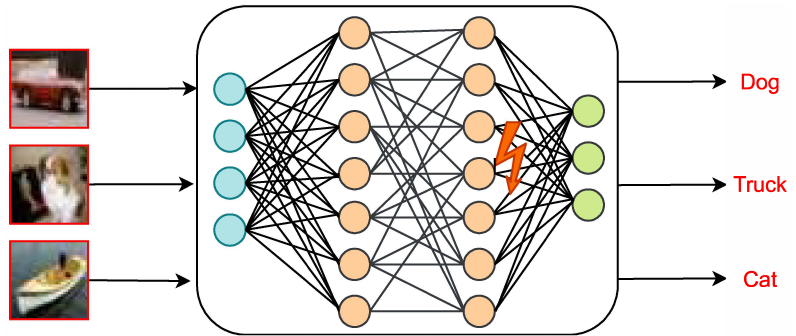
Figure 10. The untargeted attack